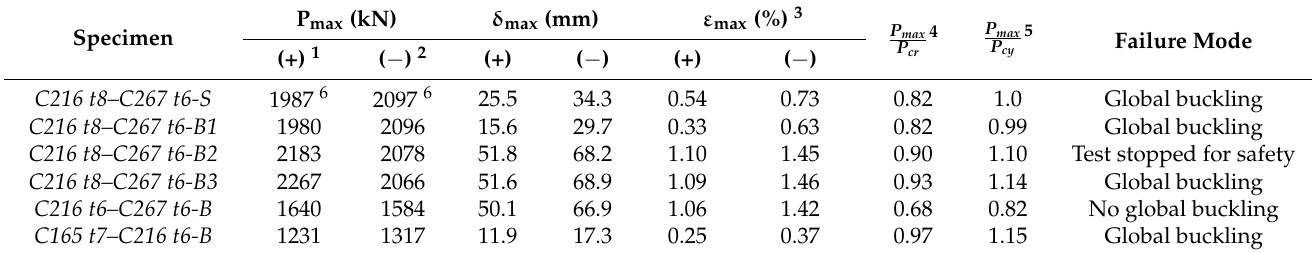
Table 4. Circular specimens test result.